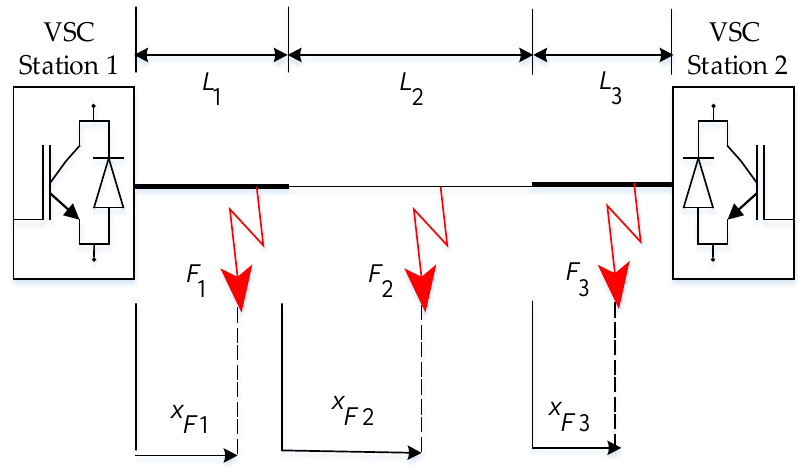
Figure 4. The direct current (dc)-link model with two overhead lines and one cable segment.